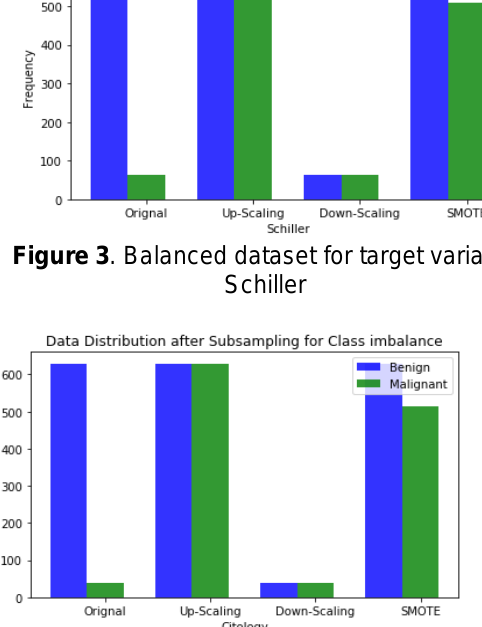
Figure 4 . Balanced dataset for target variable Cytology